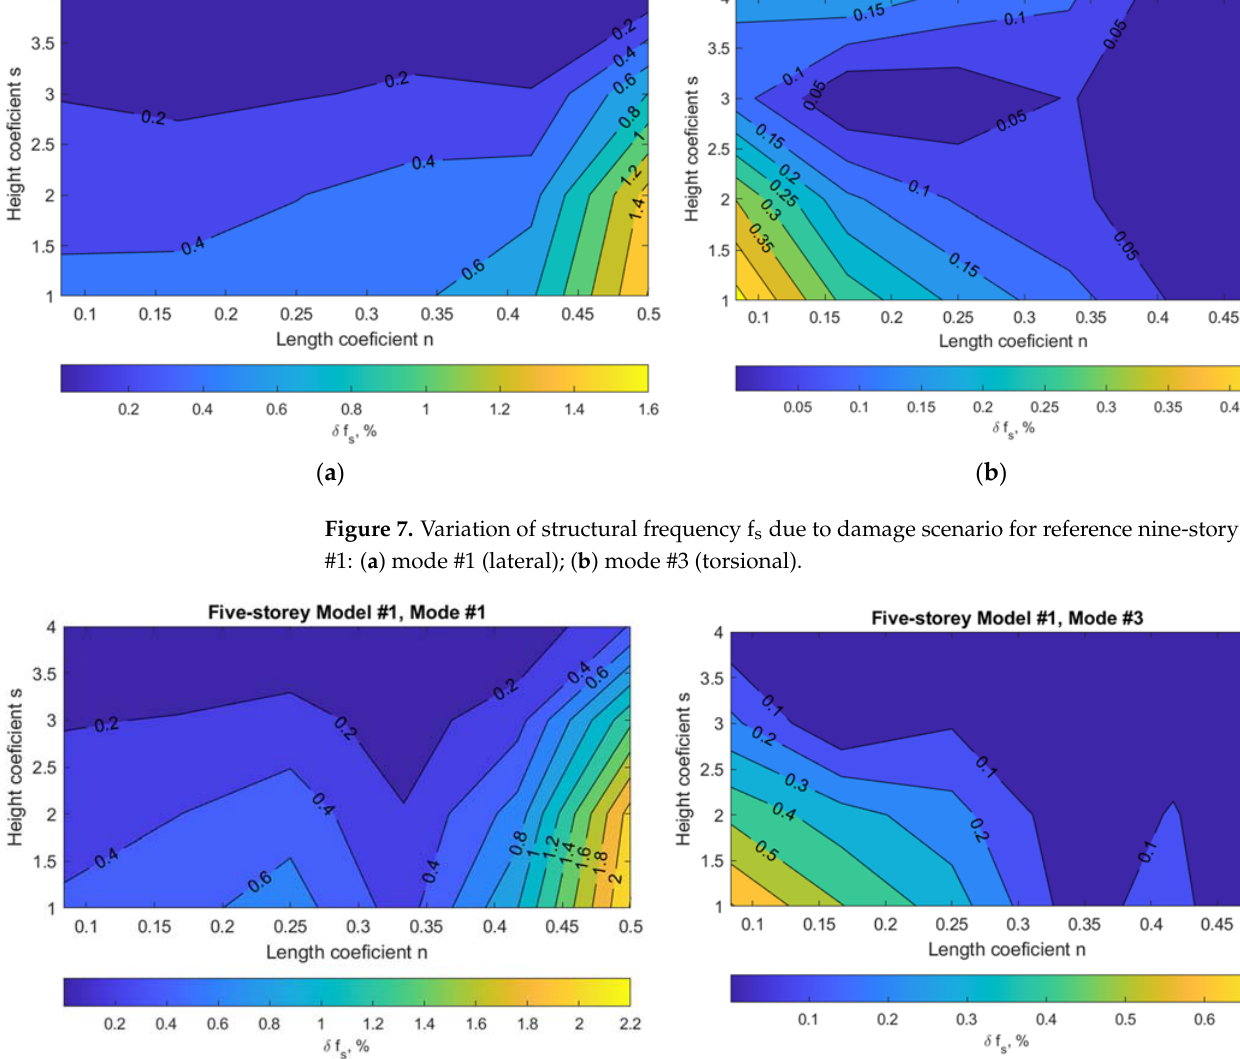
Figure 6. Damage locations for the reference model #1: ( a ) building section; ( b ) FE model of the building.